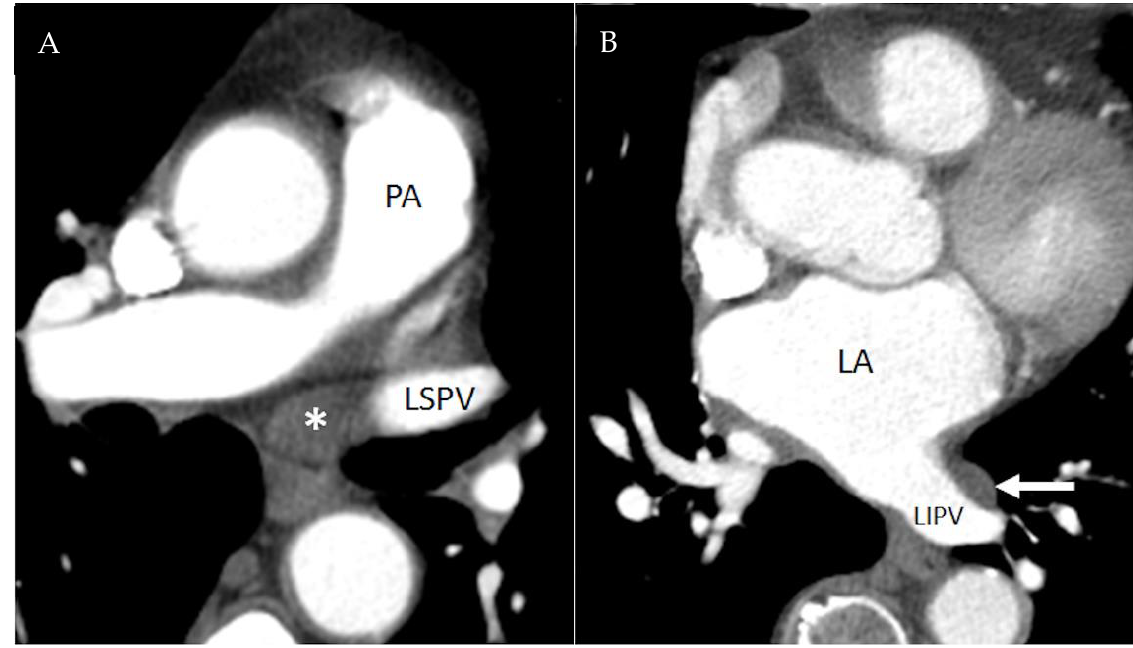
Figure 8. Normal left pulmonary venous recess. ( A ) 73 year-old woman for pulmonary nodule evaluation. Contrast-enhanced axial CT shows fluid alongside the left superior pulmonary vein in the left pulmonary venous recess (*). ( B ) 90 year-old woman with left lower lobe adenocarcinoma. Contrast-enhanced axial CT shows fluid adjacent to the left inferior pulmonary vein in the left pulmonary venous recess (arrow). Typical location, fluid attenuation, lack of mass effect, and lack of enhancement are features that help distinguish fluid from adenopathy or metastatic disease. LA = left atrium, LIPV = left inferior pulmonary vein, LSPV = left superior pulmonary vein, PA = pulmonary artery. Reprinted from Shroff G.S. et al. Pitfalls in oncologic imaging of the pericardium on CT and PET/CT [4].